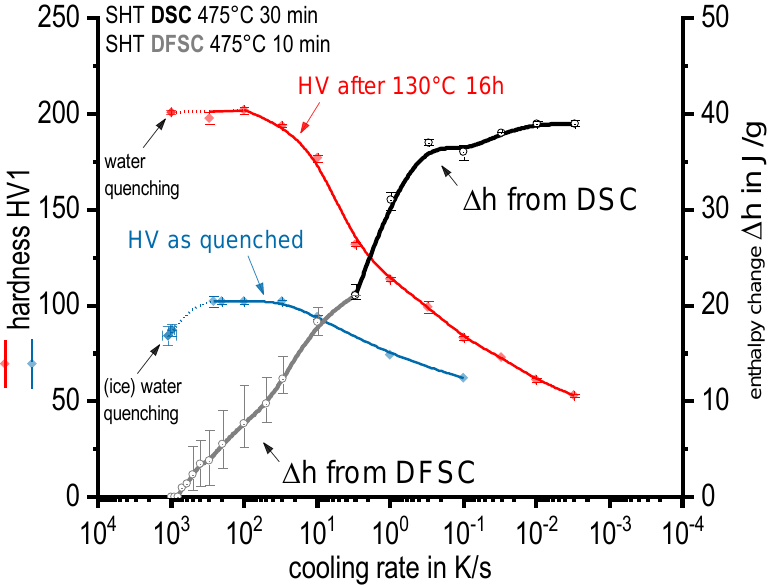
Figure 8. Enthalpy change of alloy 7068 from quench induced precipitation as well as hardness in as-quenched and aged condition.